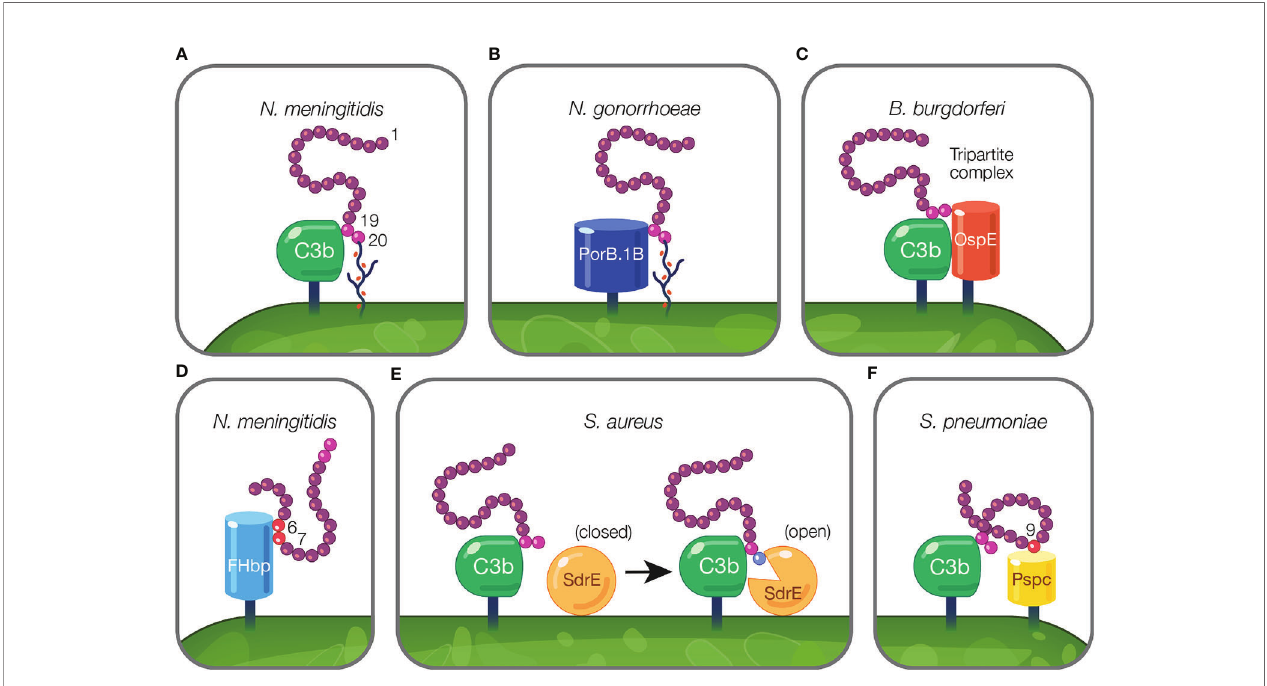
FIGURE 3 | Mechanisms of pathogens binding Factor H to evade the alternative pathway. (A) Pathogens evade complement by protecting their surfaces from complement attack using host cell markers. Neu5Ac sialylation of N. meningitidis replaces host GAGs and binds FH CCP 20 domain while maintaining the interaction between CCP 19 and deposited C3 fragments (127). (B) Pathogen sialylation promotes FH binding in the absence of complement fragments. N. gonorrhoeae FH binding protein, PorB.1B, binds FH CCP 19 domain replacing the interaction of C3b with FH CCP 19 [reviewed in (189)]. (C, D) Pathogen FH binding proteins mimic interactions between host and FH. (C) B. burgdorferi FH binding protein, OspE, forms a tripartite complex with FH where CCP 19 binds to C3 fragments and CCP 20 interacts with OspE. (D) N. meningitidis binds FH through its FH binding protein, FHbp, via FH CCPs 6 – 7. (E, F) Pathogen FH interactions that do not mimic mechanisms utilized by the host. (E) FH binding to deposited C3b on the pathogen surface results in a transformational change in S. aureus FH binding protein, SdrE, from a closed to open state. In the open state, SdrE facilitates the docking of CCP 20 into a ligand binding groove (136). (F) S. pneumoniae FH binding protein, PspC, via its tyrosine 90 residue acts like a key inserting into a hydrophobic lock formed by four hydrophobic residues of FH CCP 9